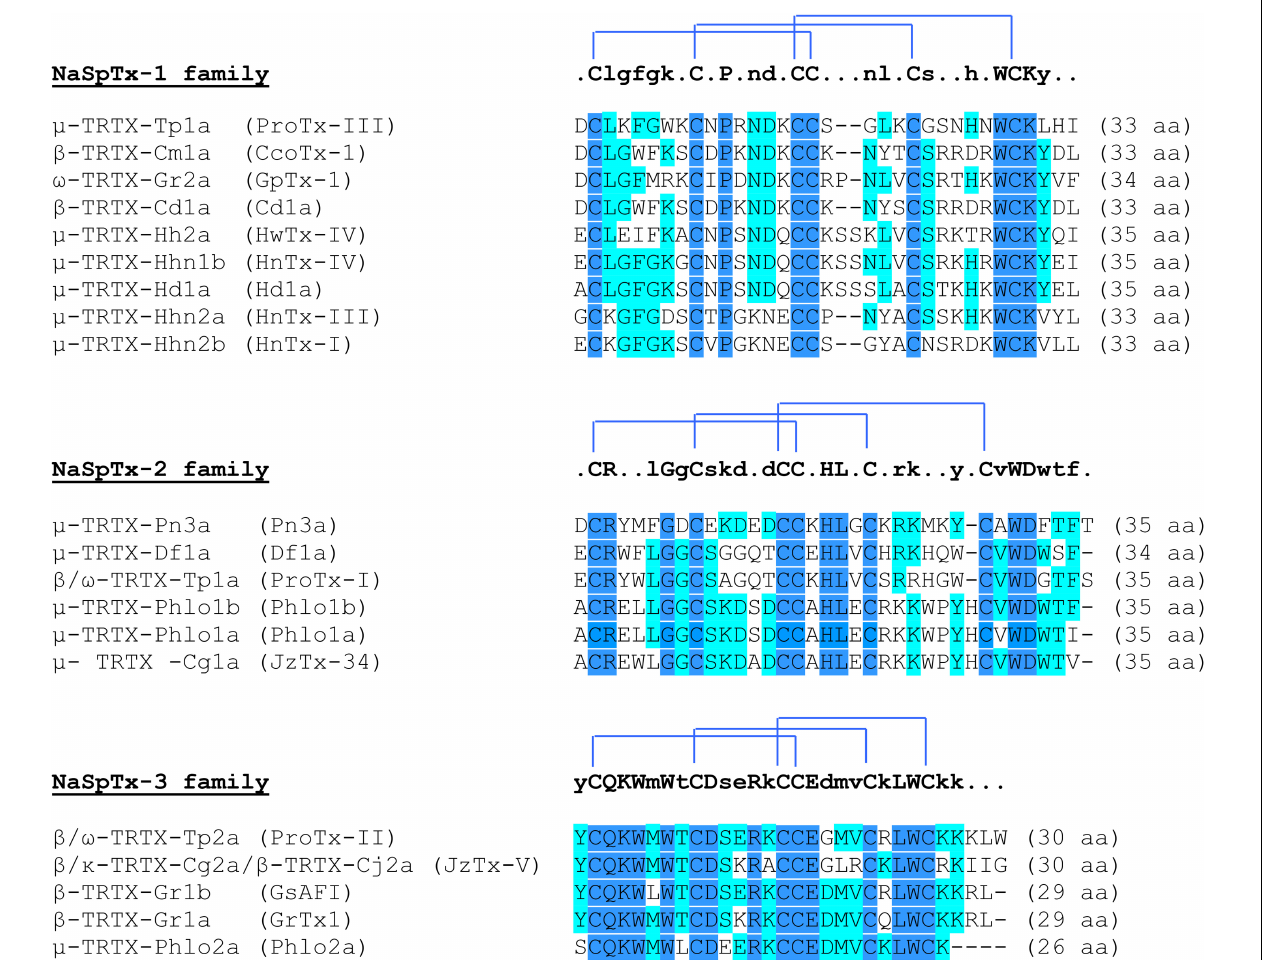
FIGURE 5 | Sequence alignment obtained by Multalin (version 5.4.1) of different potential analgesic toxins sorted by Na V spider toxins families, using their UniProtKB identifiers. The consensus sequence is shown above each alignment, with the disulfide bond connectivity. In dark blue, highly conserved amino acid residues (100%), and in light blue, poorly conserved amino acid residues ( > 50%). The Greek letter(s) before the toxin name is associated to its type of action: µ for Na V channel inhibition, β for shift in the voltage-dependence of Na V channel activation, ω for Ca V channel inhibition, and κ for K V channel inhibition. ProTx,